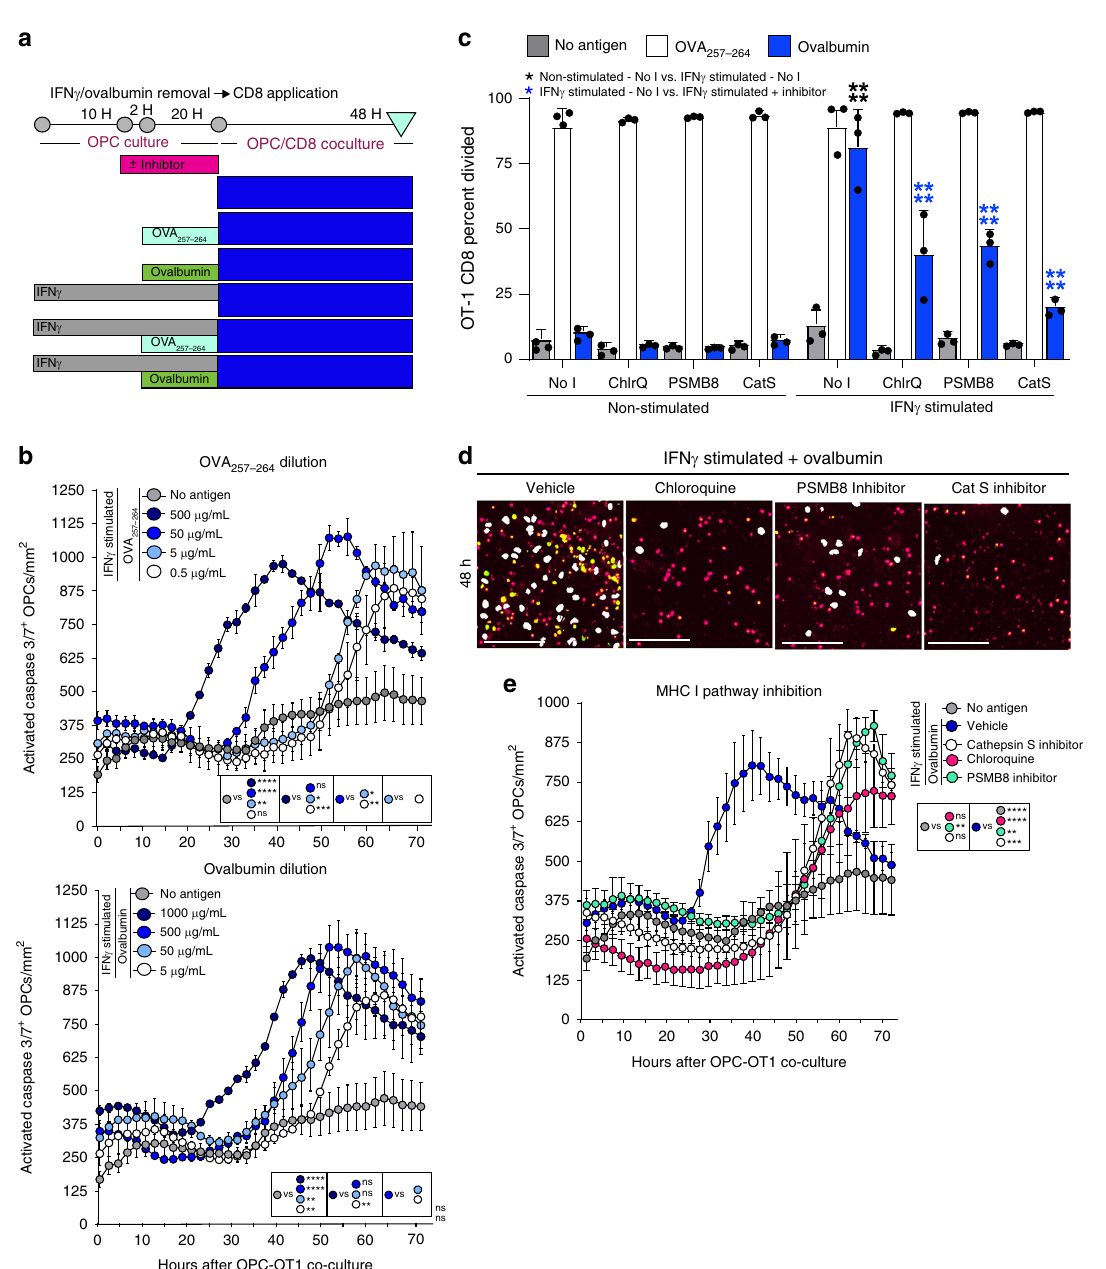
Fig. 7 Antigen concentration and antigen pathway inhibitors modulate cytotoxicity. a Timeline of experimental methodology and treatment times. b Quanti fi cation of time-lapse imaging of OVA 257 – 264 peptide (0.5 – 500 μ g range) (top) [(500 μ g/mL vs.5.0 μ g/mL mean diff = 10320; 95% CI = 1902 – 18738)] and ovalbumin (5 – 1000 μ g range) (bottom) [(1000 μ g/mL vs.50 μ g/mL mean diff = 12641; 95% CI = 4199 – 21083)] concentrations added to OPCs stimulated with IFN γ and antigen prior to CD8 addition. c Proliferation analysis of OPC-CD8 co-cultures treated with antigen cross-presentation pathway inhibitors. No inhibitor (No I) or each inhibitor were added to OPC culture for two hours prior to the addition of OVA 257 – 264 (white) or Ovalbumin (blue), and then left in wells during processing and presentation phase. Chloroquine was added at 100 μ M. ONX-0914, PSMB8 inhibitor was added at 30 nM. Cathepsin S inhibitor was added at 10 nM. In all, 48 h after CD8 co-culture was initiated cell proliferation of the V β 5, CD3, CD8a population of CD8s was analyzed for cell division and total percent divided. Signi fi cance for all quanti fi ed data was either assessed by two-way ANOVA analysis followed by a Tukey ’ s multiple comparison analysis [(NoT vs. Chloroquine mean diff = 40.8; 95% CI = 27.1 – 54.4, NoT vs. ONX-0914 mean diff = 37.6; 95% CI = 24.0 – 51.3, NoT vs. Cathepsin S inhibitor mean diff = 60.9; 95% CI = 47.2 – 74.6)]. Error bars in all graphs represent standard deviation from three experiments. d , e Time-lapse images and quanti fi cation of from 0 to 60 h with the antigen presentation pathway inhibitors; Chloroquine (pink circle; 300 μ M) [(mean diff = 18203; 95% CI = 11864 – 24542)], Cathepsin S inhibitor (white circle; 30 nM) [(mean diff = 9775; 95% CI = 3436 – 16114)], PSMB8 inhibitor (green circle; ONX-0914; 30 nM) [(mean diff = 13059; 95% CI = 6720 – 19398)]. Signi fi cance of differences between conditions is shown in the legend for each fi gure. Signi fi cance was determined by area under the curve analysis followed by one-way ANOVA and Tukey ’ s multiple comparisons test. Error bars represent standard deviation from 3 to 5 experiments. ( P * ≤ 0.05, ** ≤ 0.01, *** ≤ 0.001, **** ≤